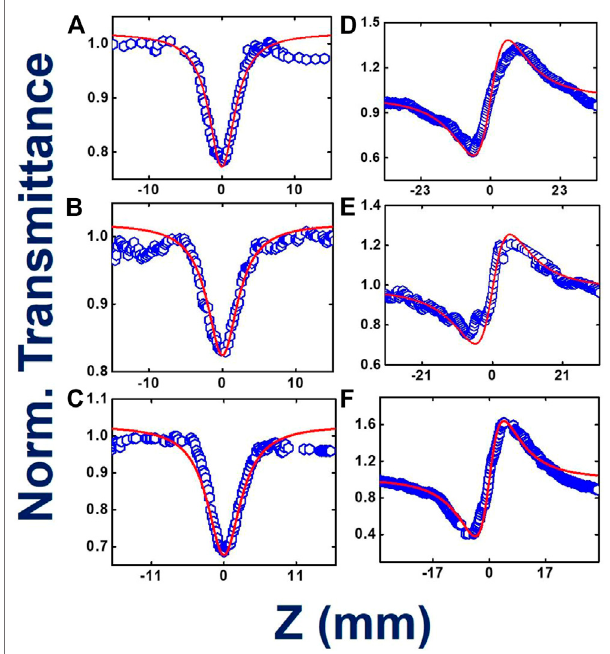
FIGURE 6 | Femtosecond MHz pulses involved experimental and theoretically fi tted Z-scan data in open aperture (A – C) and closed aperture con fi gurations (D – F) , for TMPc , Cu-TMPc , Zn-TMPc , respectively, in thin fi lm form. Open symbols are the experimental data while the solid lines represent theoretical fi